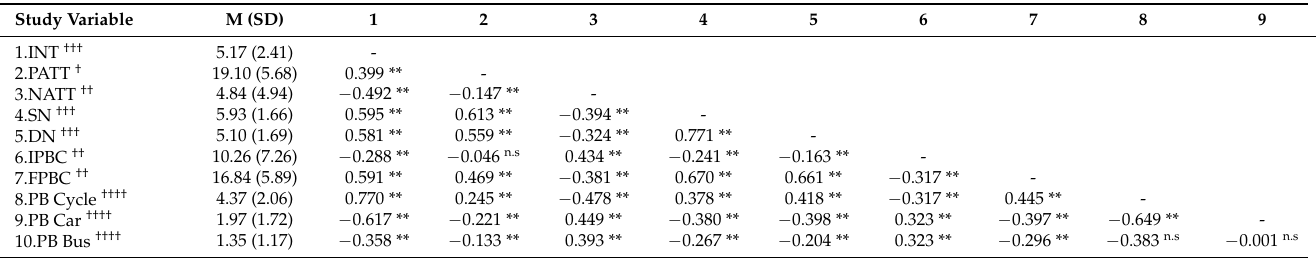
Table 3. Means, standard deviations and zero-order Pearson correlations among the various cycling components. Study Variable